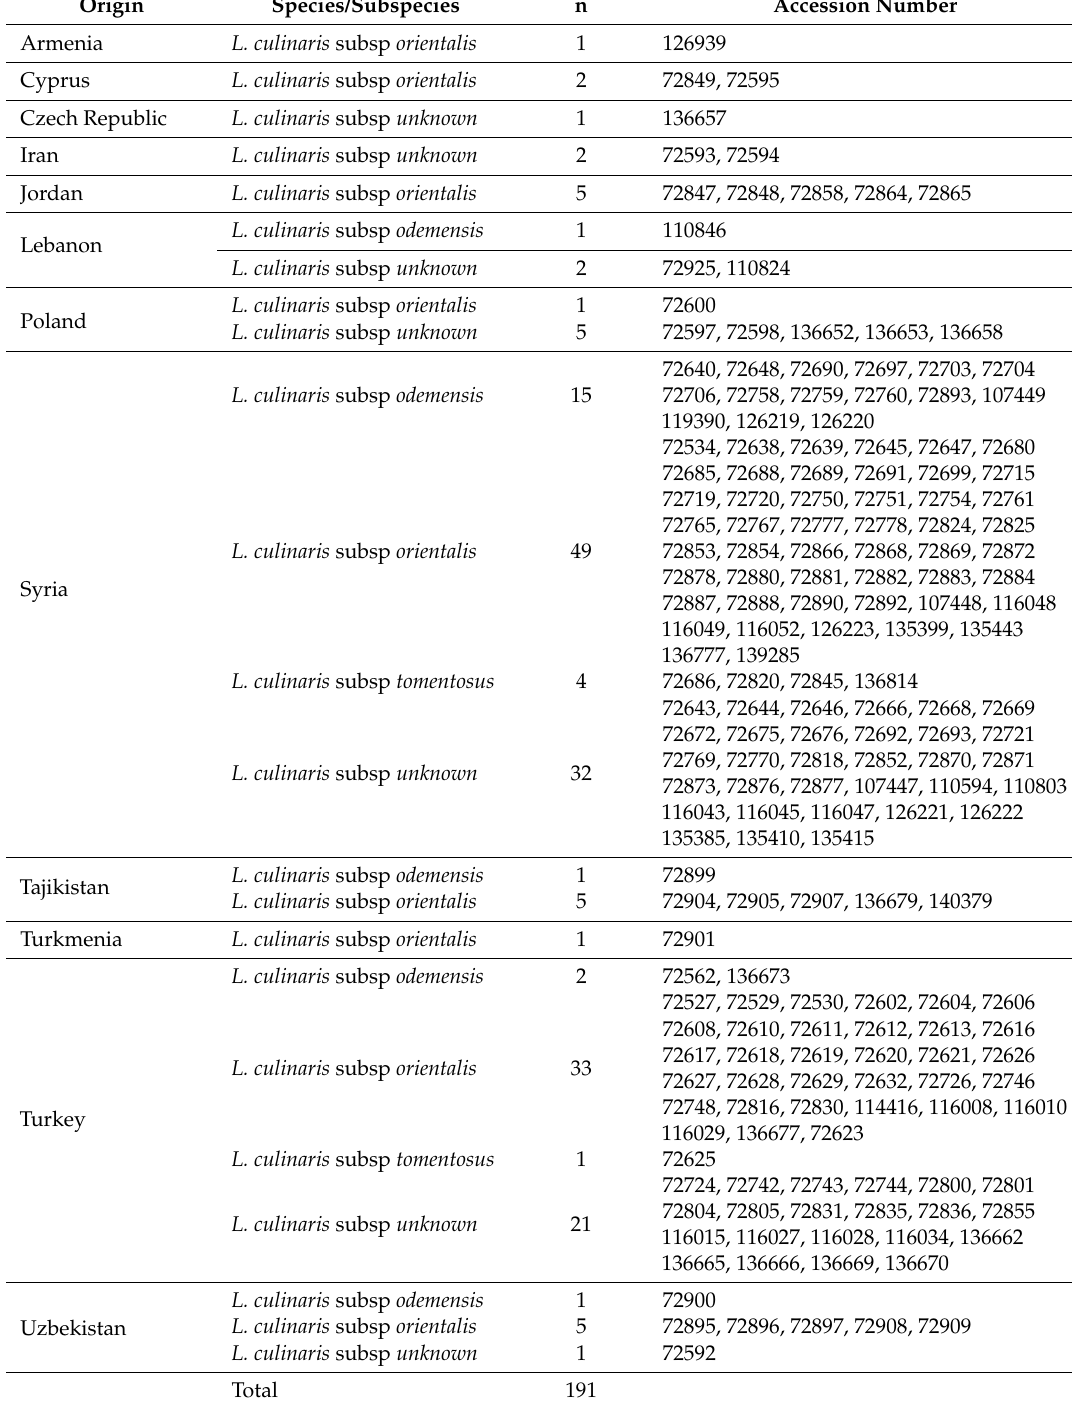
Table 2. Origin, species/subspecies and accession numbers of 191 lentil wild accessions used in the ICARDA